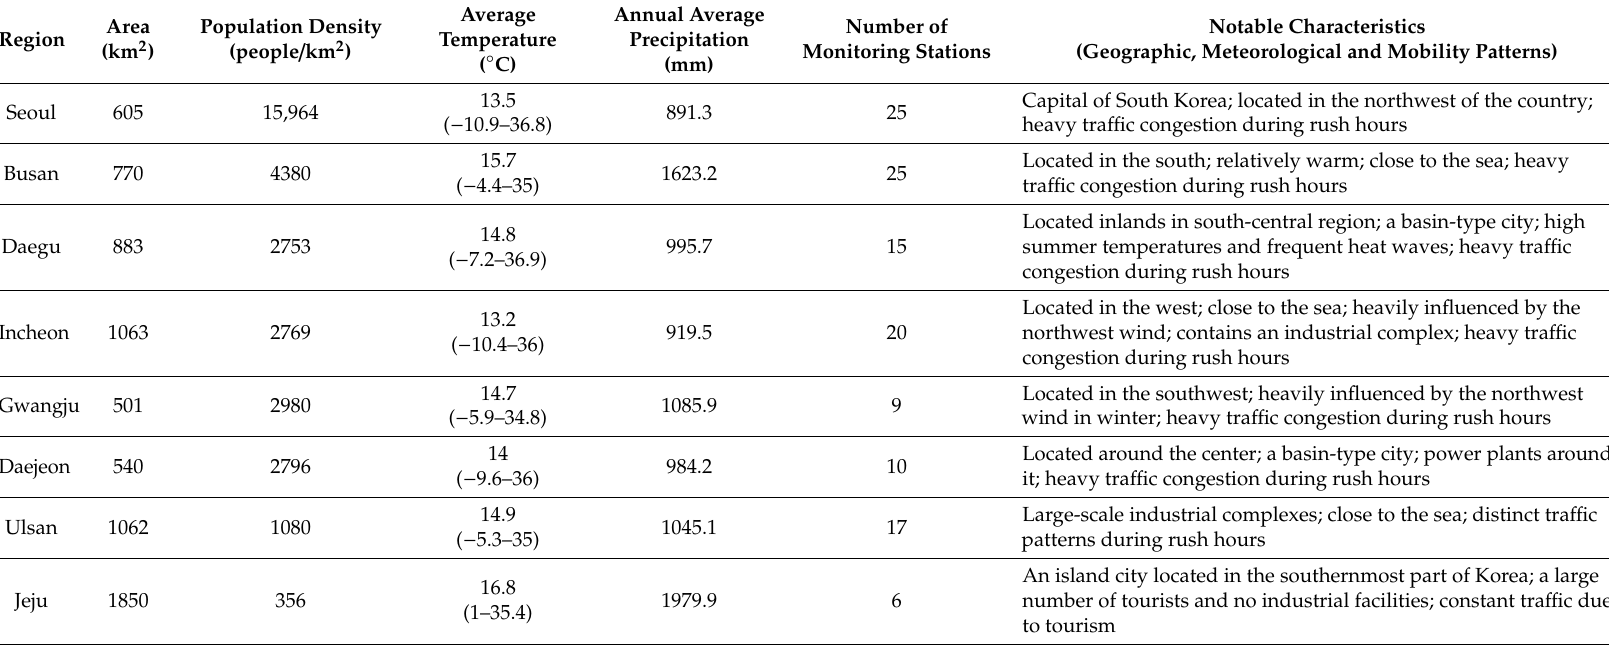
Table 1. Geographic, climatic, socio-economic and other notable characteristics in the eight